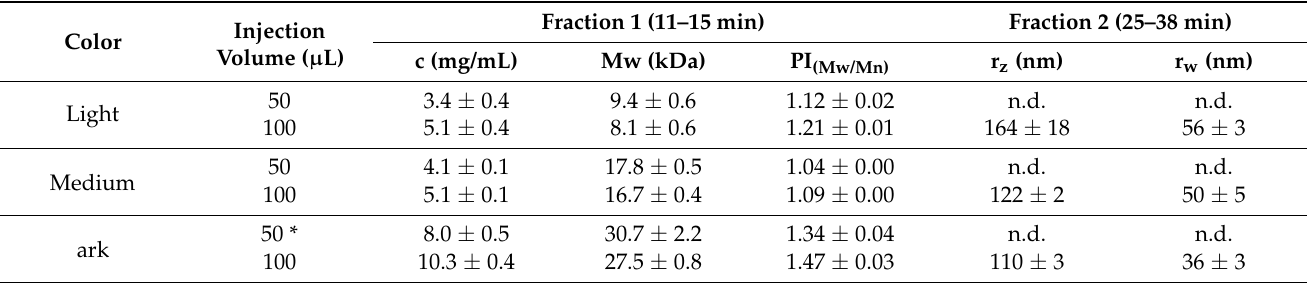
Table 4. Summary of AF4 results for fraction 1 and fraction 2 in the different diluted beer samples. Values present the average and standard deviation of 3 or 6 (*) measurements. n.d. = not determined.